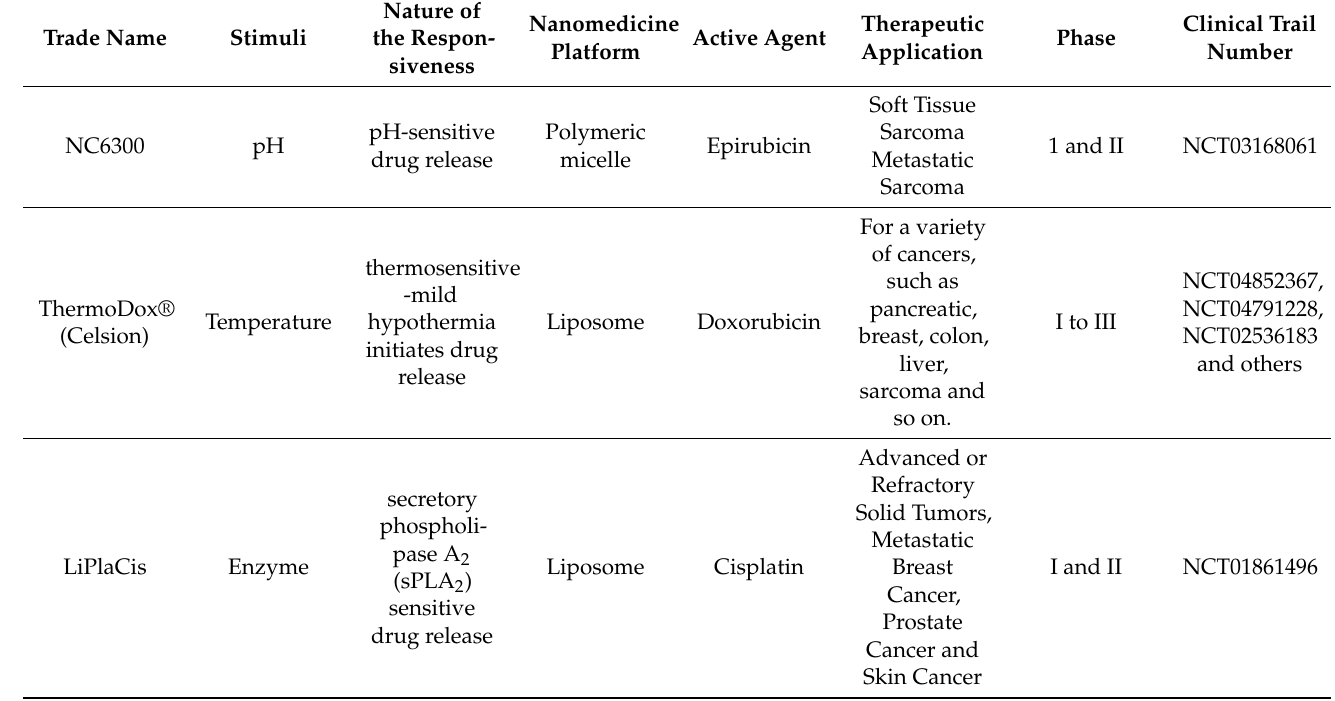
Table 1. Bio-Responsive Polymer-based Nanomedicines that are in the clinical